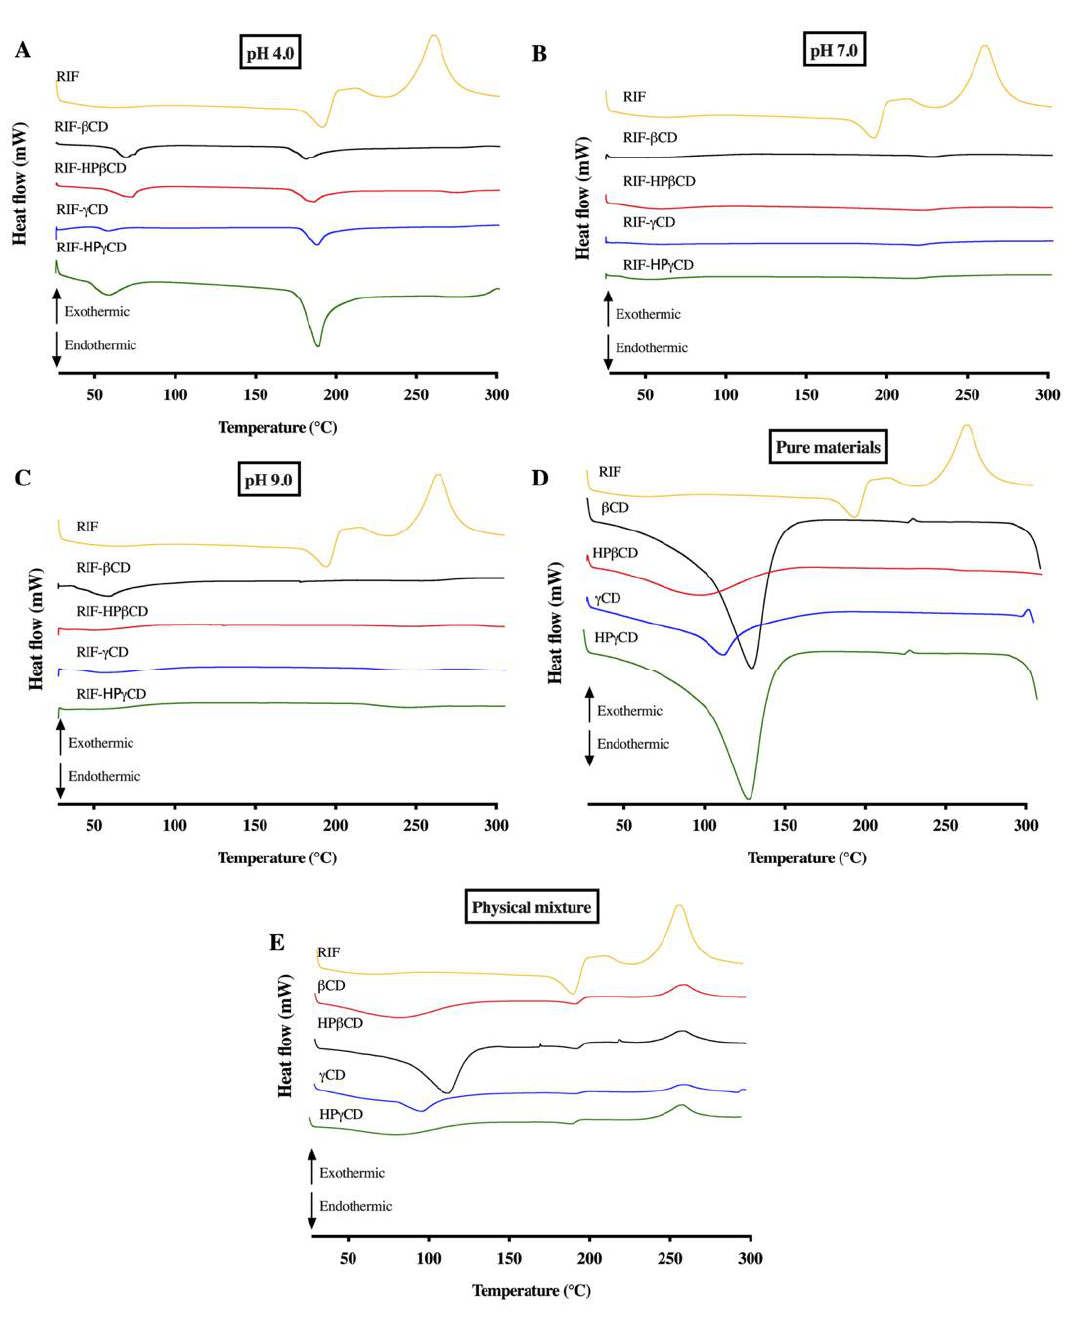
Figure 6. DSC thermograms of RIF-CD complexes with several types of CD at ( A ) pH 4.0, ( B ) pH 7.0, and ( C ) pH 9.0. The thermograms of RIF-CD complexes compared to thermogram of ( D ) pure RIF, pure CD, and ( E ) physical mixture. Exothermic is up and endothermic is down.